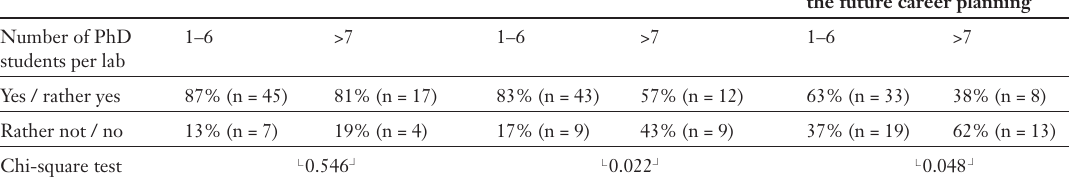
Evaluation of super- vision and mentoring with respect to the number of fellow PhDs in the laborato- ries.